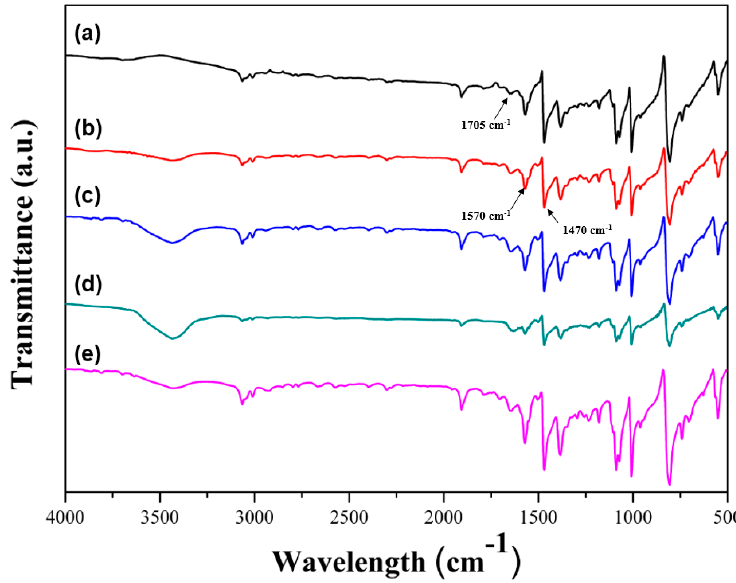
Figure 1. Fourier Transform Infrared spectra of the PPS/MWCNTs composites. ( a ) Neat PPS, ( b ) PPSP1, ( c ) PPSA1, ( d ) PPSHP1, and ( e ) PPSS1.